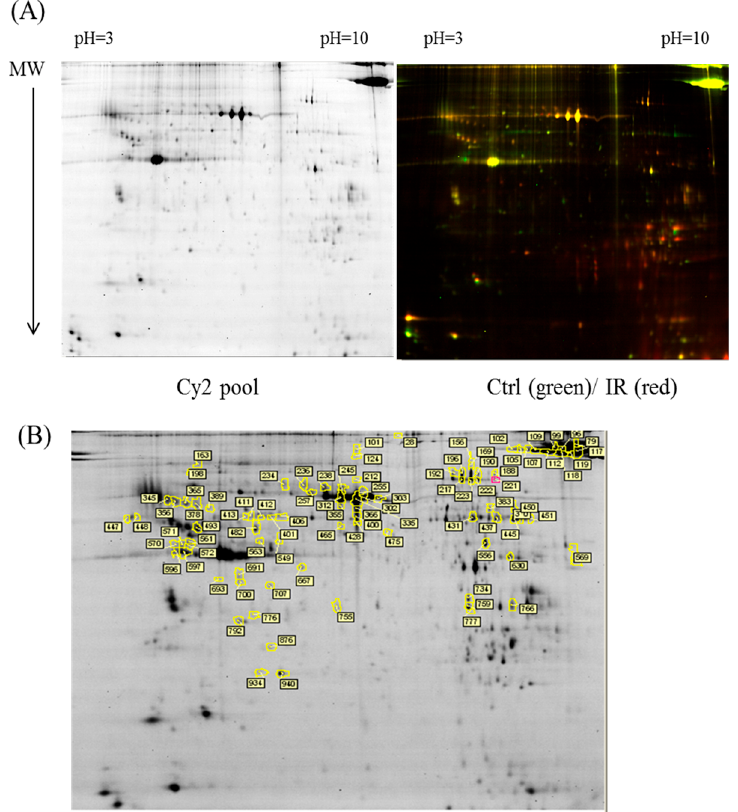
Figure 2. Comparison of proteomics between the IR injury and control groups in conjunctiva. ( A ) Schematic representation of the 2D-DIGE workflow for monitoring the differentially expressed proteins in the conjunctiva of the IR injury and control groups; ( B ) 2D-DIGE images of the tissue samples analyzed using DeCyder software; the differentially expressed identified protein features are annotated with circles and spot numbers.